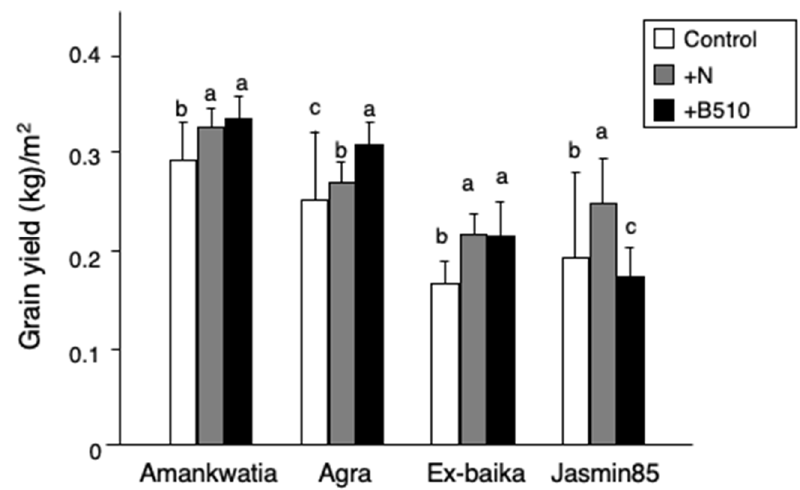
Figure 5. The effect of B510 inoculation on rice growth managed under field conditions in Golinga, Ghana. A field test was performed in Golinga, Ghana using 4 cultivars (Amankwatia, Agra, Ex-baika, and Jasmine85). Plants were grown in nursery field, and inoculated B510 on the young seedling. After 2 dpi, the plants were transferred to the field. Grain yield was measured after 2 months. The bar colors: non-treated control (white), applied chemical fertilizer (gray) and inoculated with B510 (black). Values presented are the average SD from three replicates per area. Statistical analysis was performed, different letters (a, b, c) indicate significant difference between treatments (Student–Newman–Keuls (SNK) test, p < 0.05, n = 9).